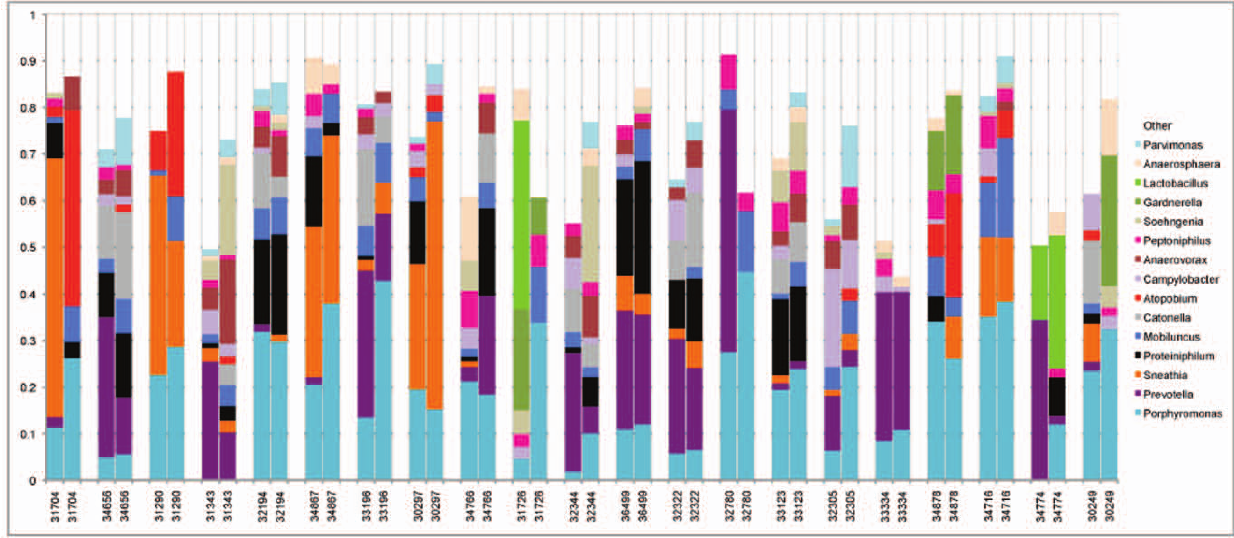
Figure 5. Genera of macaque lower genital tract bacteria. The genital microbiota in 21 macaques was identified at two times (approximately 8 months apart). Each group of two bars represents the relative proportions of 16S sequences indentifying bacterial genera in one macaque at the two different time points. Only the 15 most predominant genera are displayed for clarity. doi:10.1371/journal.pone.0052992.g005 PLOS ONE |